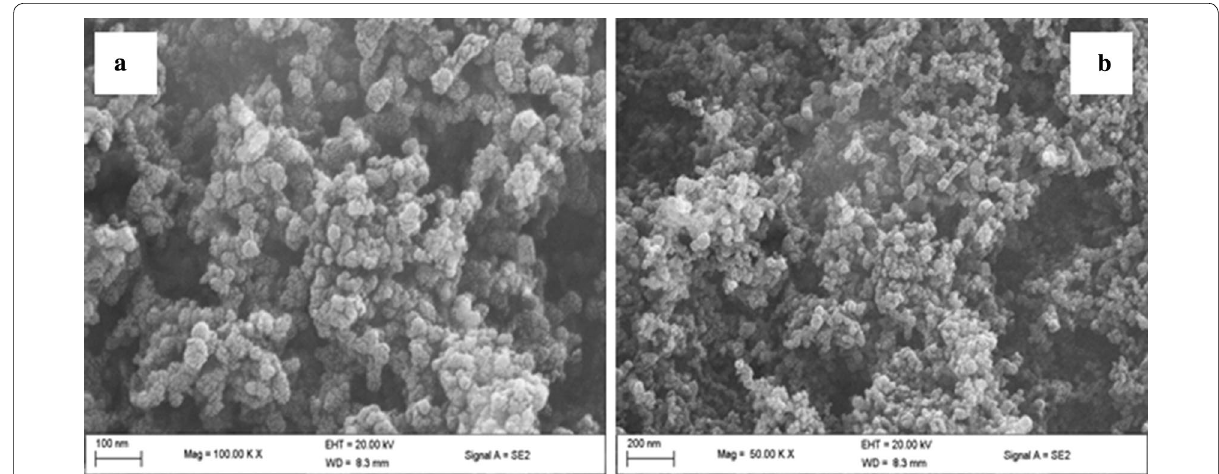
Fig. 3 SEM image of biodiesel–fossil diesel at an associated magnification of